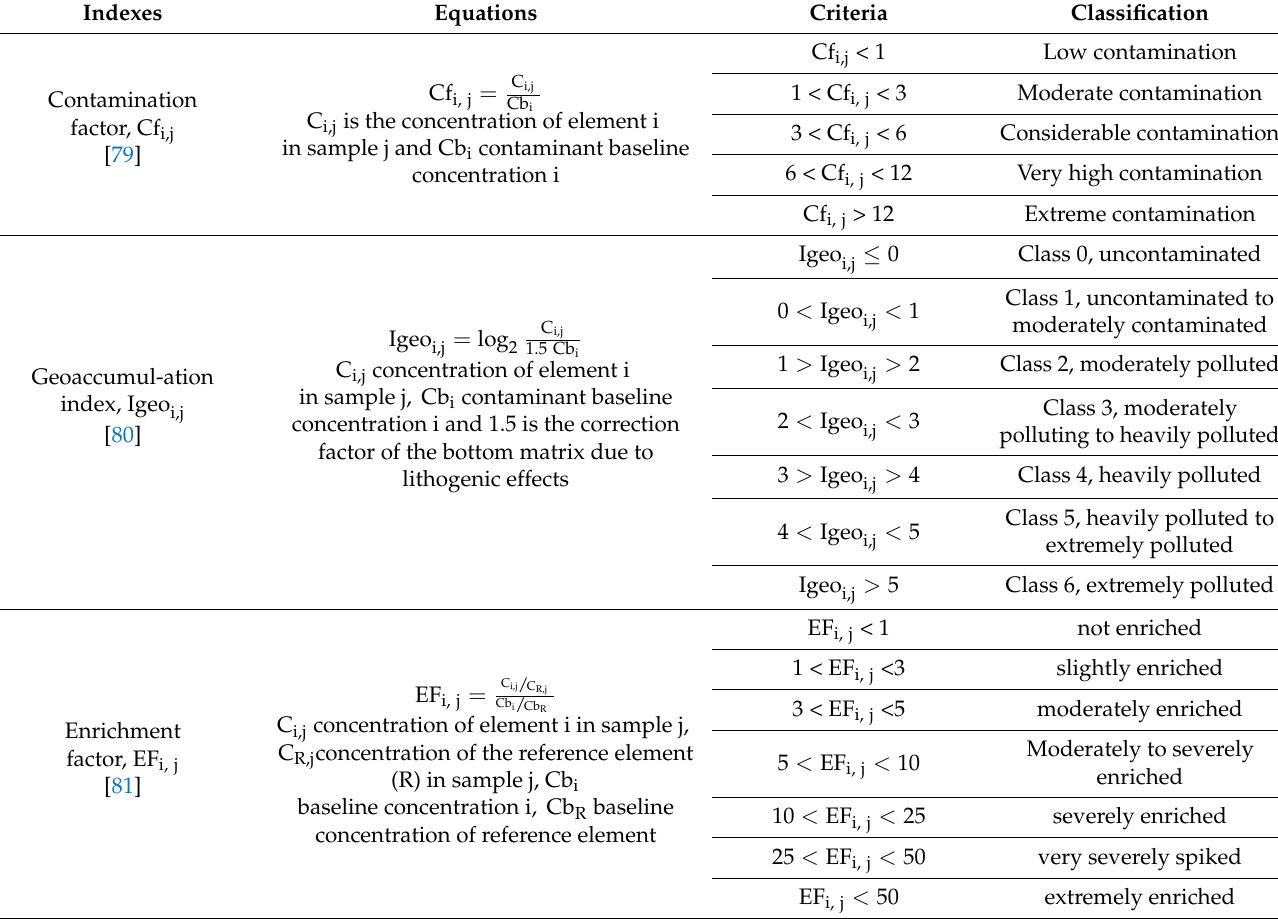
Table 1. Sediment contamination assessment index. Definition and classification criteria considered in this